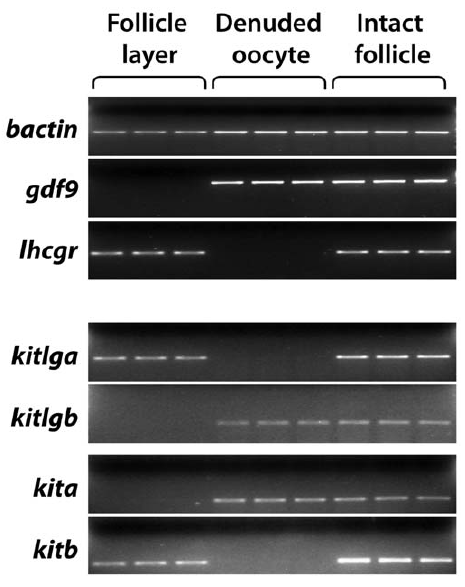
Figure 1. Distribution of the Kit system within the zebrafish follicle. The somatic follicle layer was separated from the oocyte followed by RNA extraction and semi-quantitative PCR detection in the two compartments (follicle layer and denuded oocyte). Each sample represents the total RNA pooled from 5 follicles. The housekeeping gene bactin was used as the internal control for all samples, whereas gdf9 and lhcgr were used as the markers for denuded oocytes and somatic follicle layers,